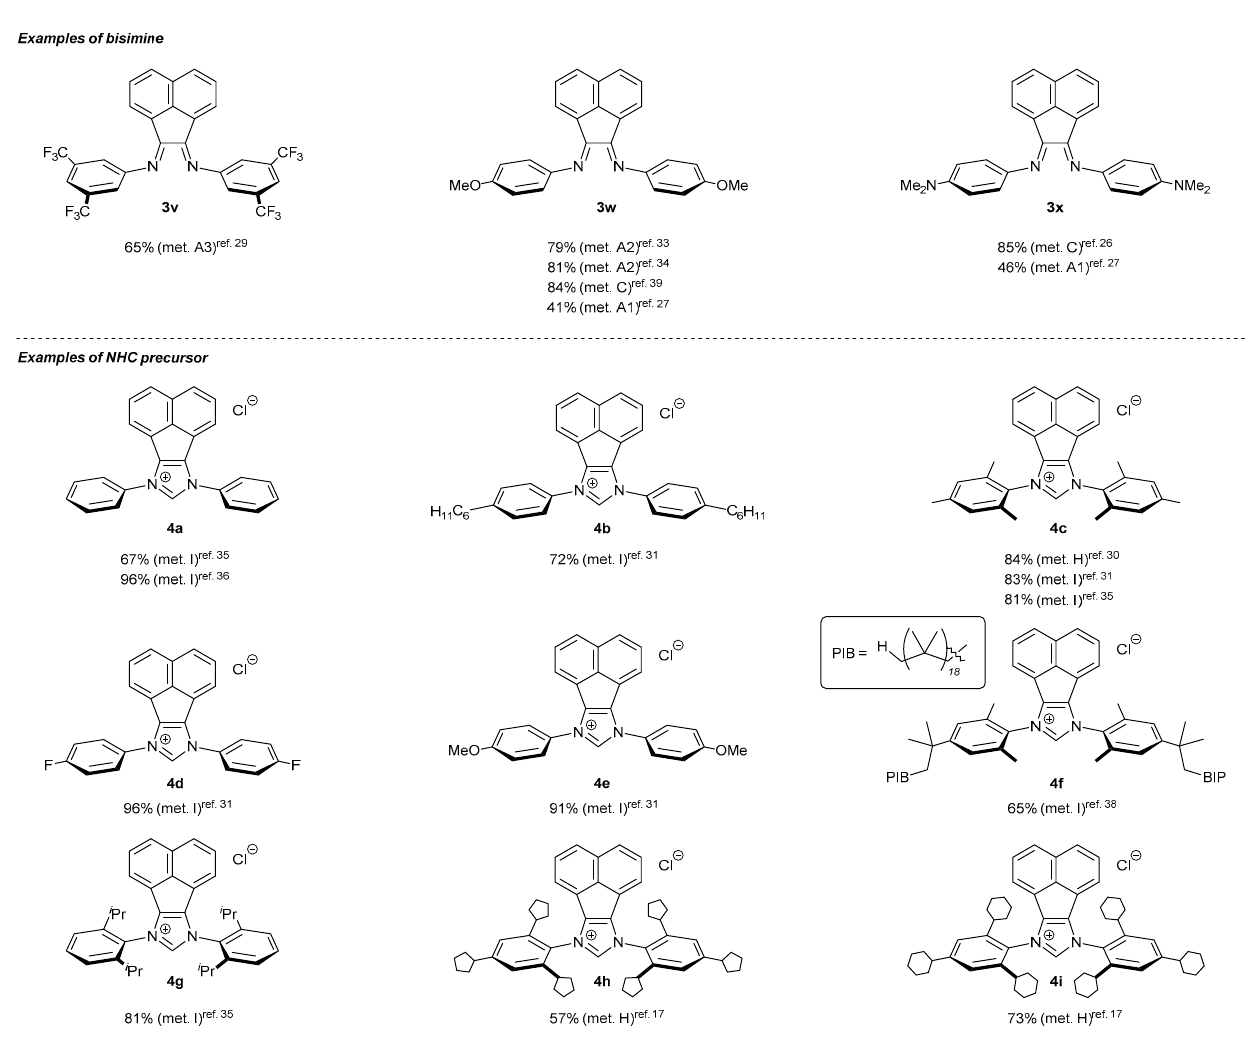
Scheme 1. Structure of bisimine 3 and NHC precursors 4 bearing an acenaphthylene subunit. a The yield of bisimine 3a formation was not provided. formation was not